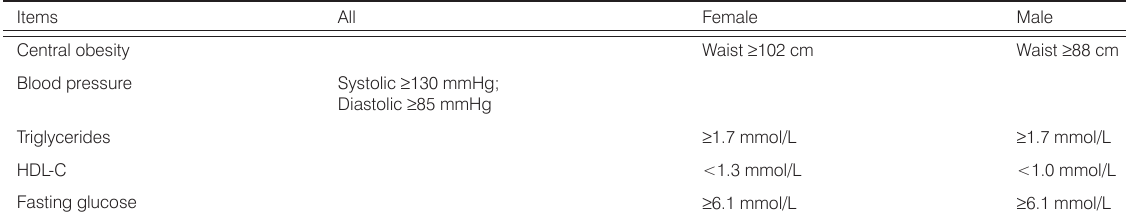
Table 1. NCEP-ATP III definition of MS in adults.